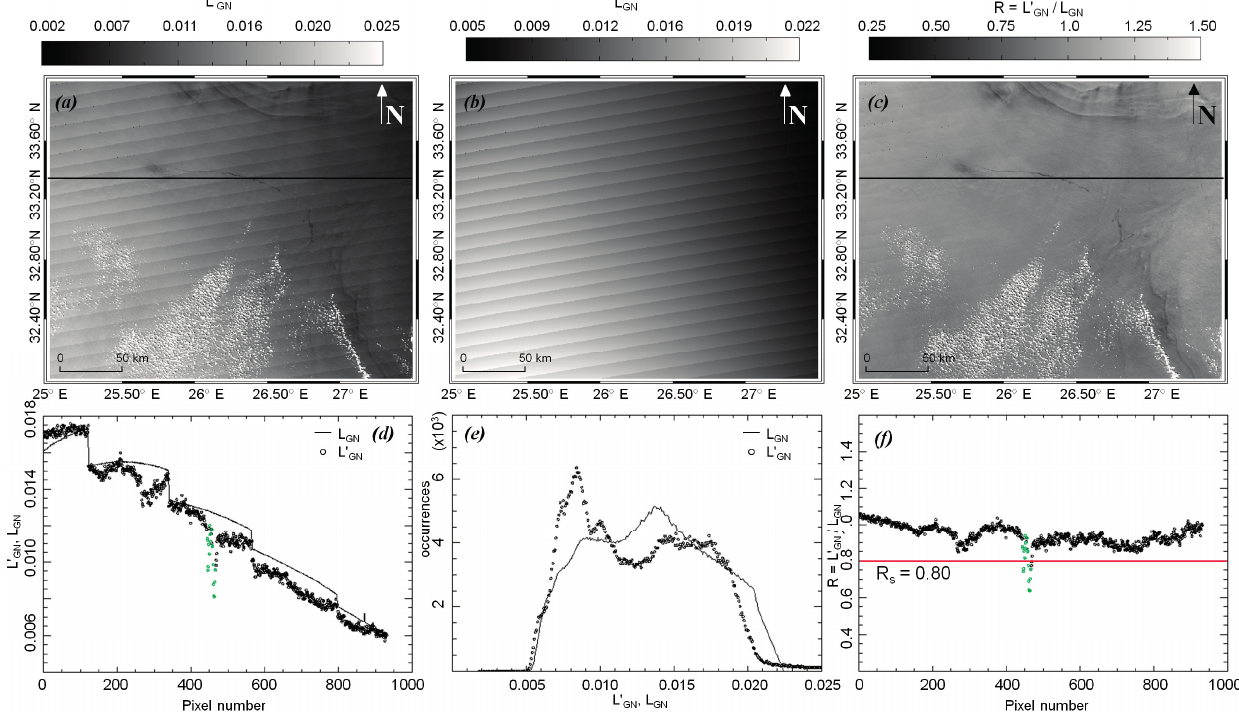
Figure 3. ( a ) MODIS-derived L' GN (bias-corrected), relative to Scene 6 of Table 1 (Crete, negative oil spill-water contrast); ( b ) L GN from Cox and Munk; ( c ) R = L' GN / L GN ; ( d ) comparison between L GN (solid line: Cox and Munk (1954) isotropic) and L' GN (dotted line) along the transect (black line in (a)). Green dots denote the oil spill pixels in the corresponding ROI; ( e ) L GN and L' GN histograms; ( f ) R values along the transect (black line in (c)) with green dots for oil spill pixels. The solid red line represents the oil spill separation index value R s from Table